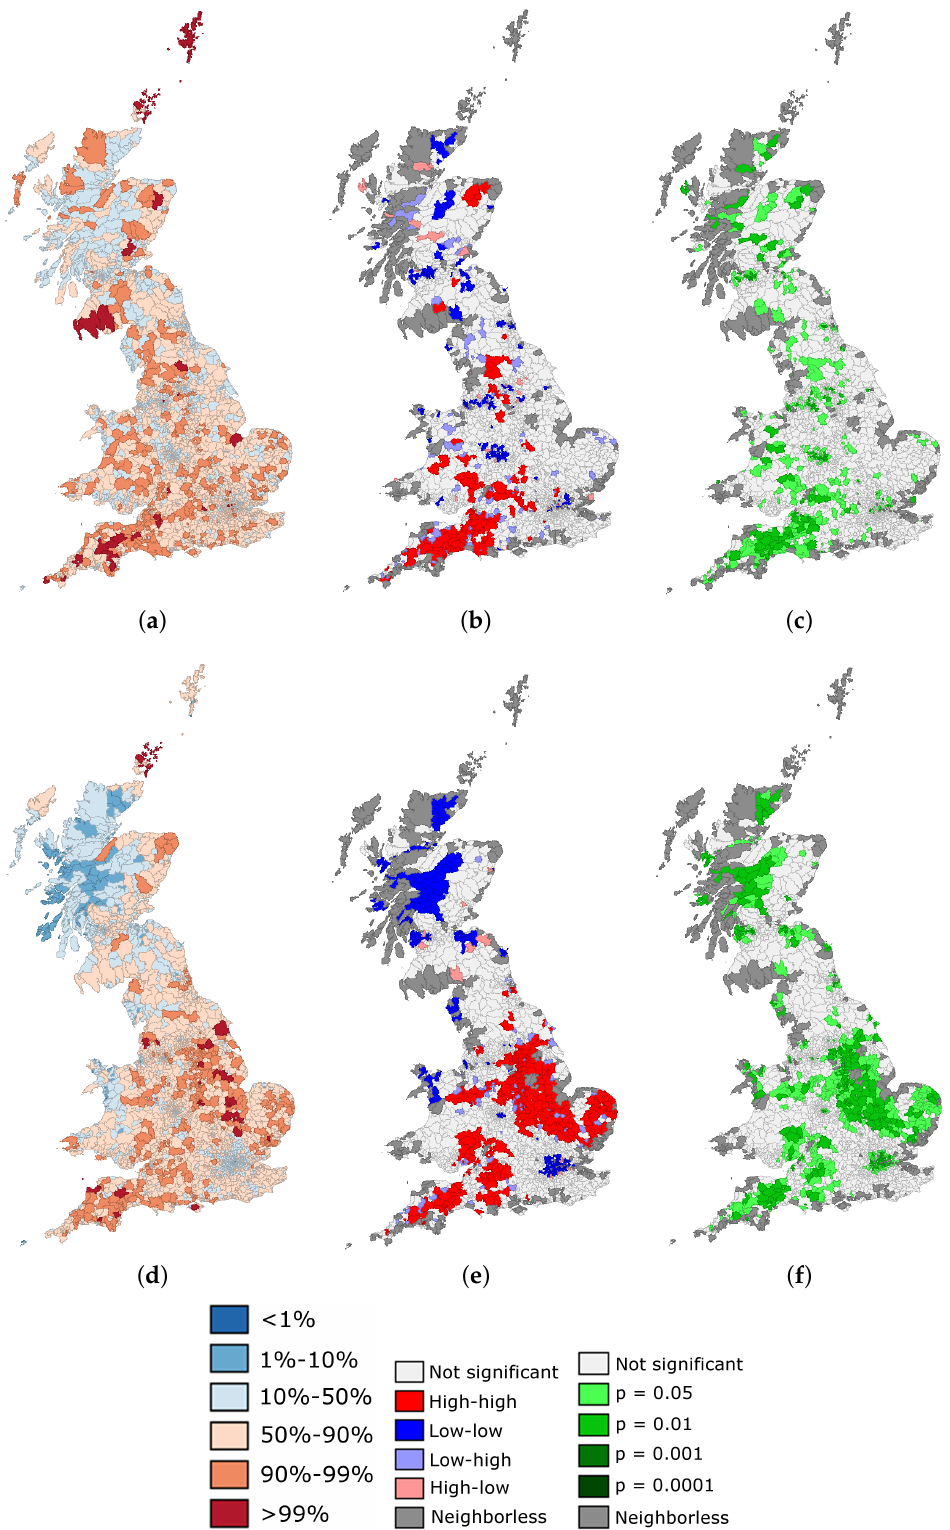
Figure 7. Indicators of local clustering of capacity (per (B) in Section 3). ( a ) Distribution of capacity by percentile (8 April 2010); ( b ) Clusters of capacity by type (8 April 2010); ( c ) Significance level of clusters (8 April 2010); ( d ) Distribution of capacity by percentile (30 September 2015); ( e ) Clusters of capacity by type (30 September 2015); ( f ) Significance level of clusters (30 September